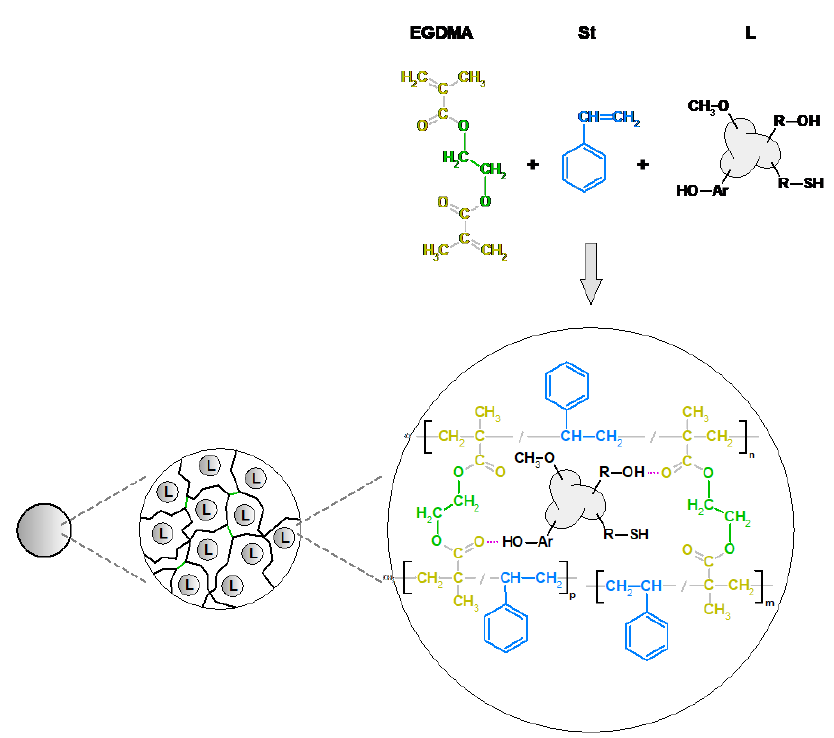
Figure 2. Possible chemical structure of polymeric microspheres.